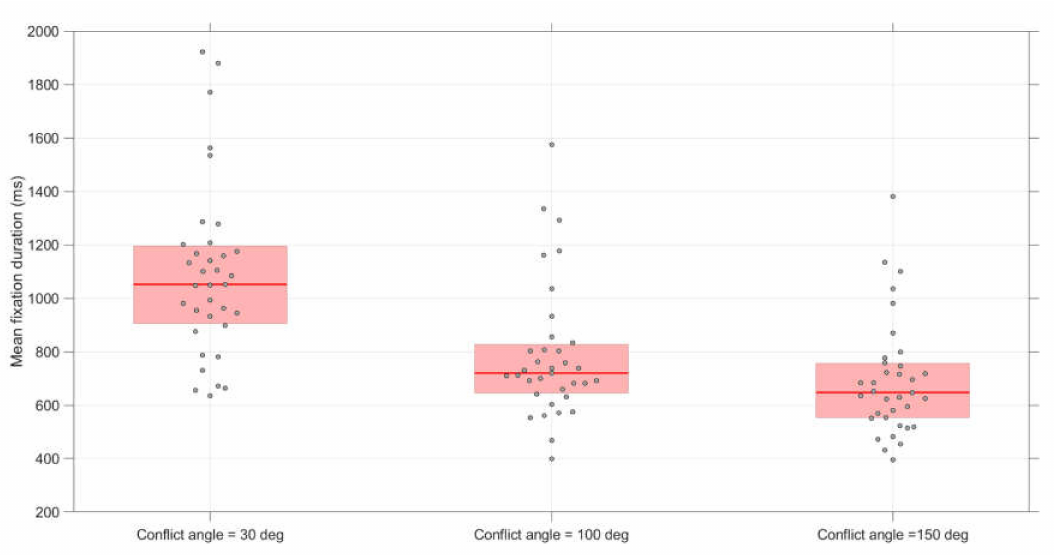
Figure 9. Boxplots of the mean fixation duration per conflict angle. The score for each participant represents the average of 12 scenarios (conflict scenarios and non-conflict scenarios